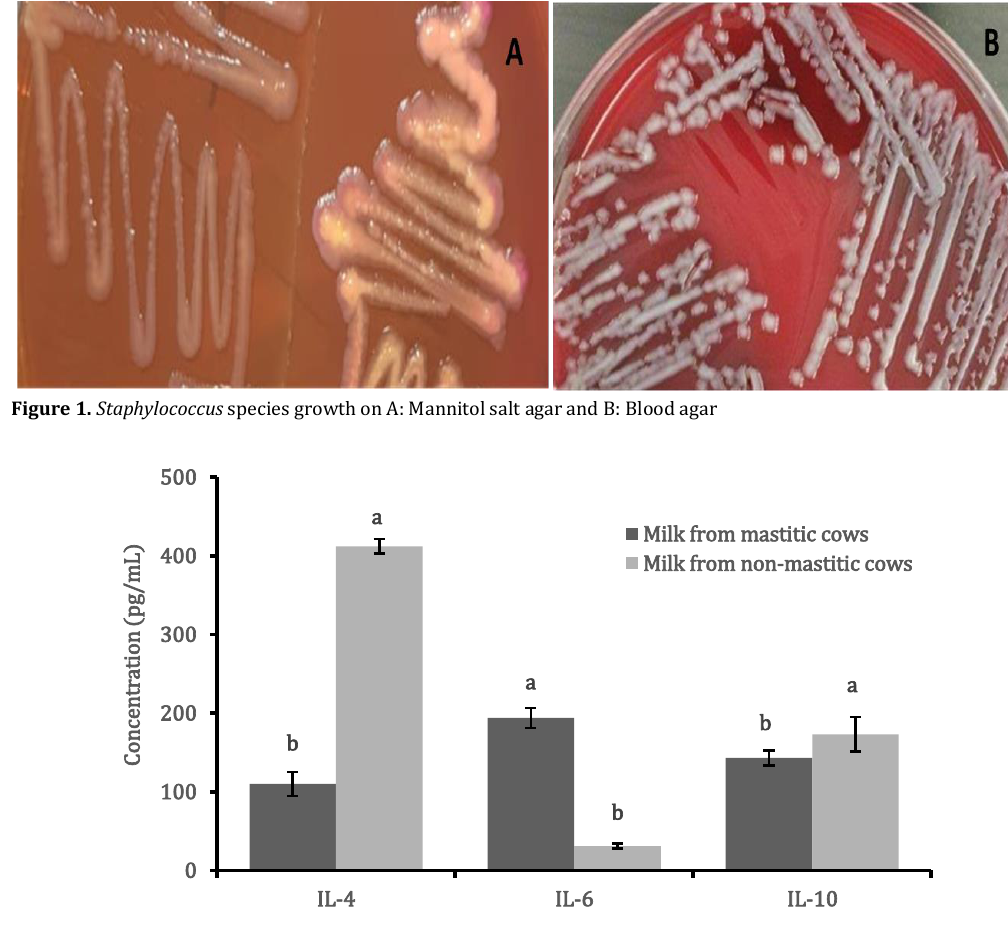
Figure 2. Concentration of Interleukins (IL)-4, -6, and -10 in milk samples collected from mastitic and non-mastitic